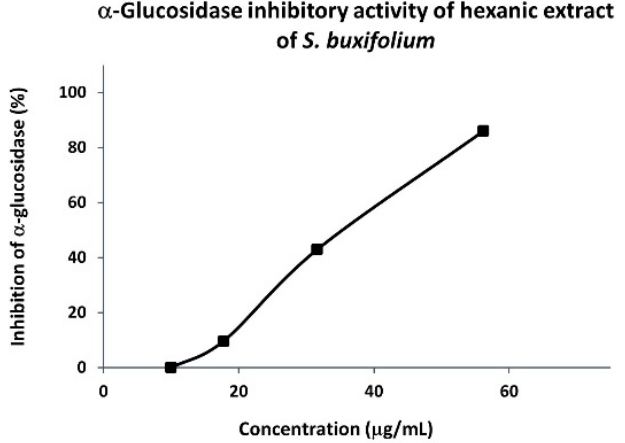
Figure 4. α -Glucosidase inhibitory activity of the hexanic extract of S. buxifolium .